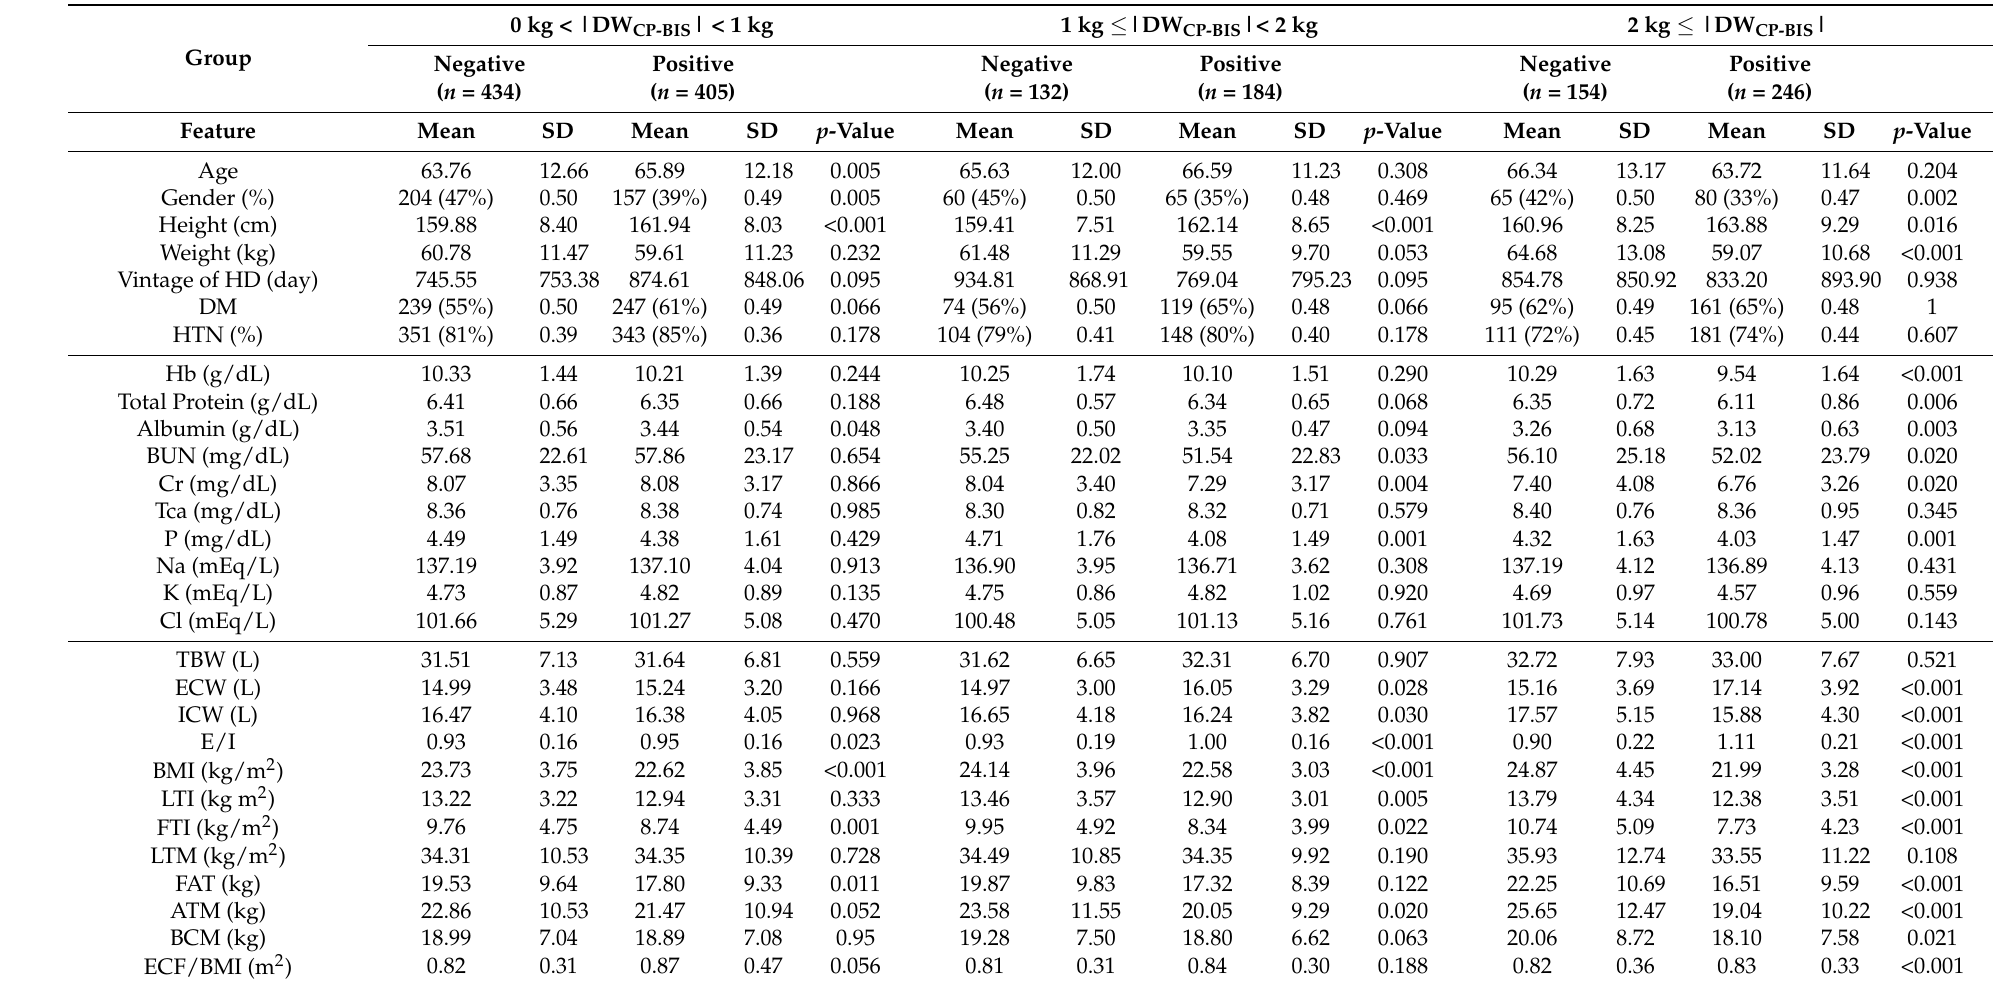
Table 2. Clinical characteristics as subdivision of DW CP-BIS